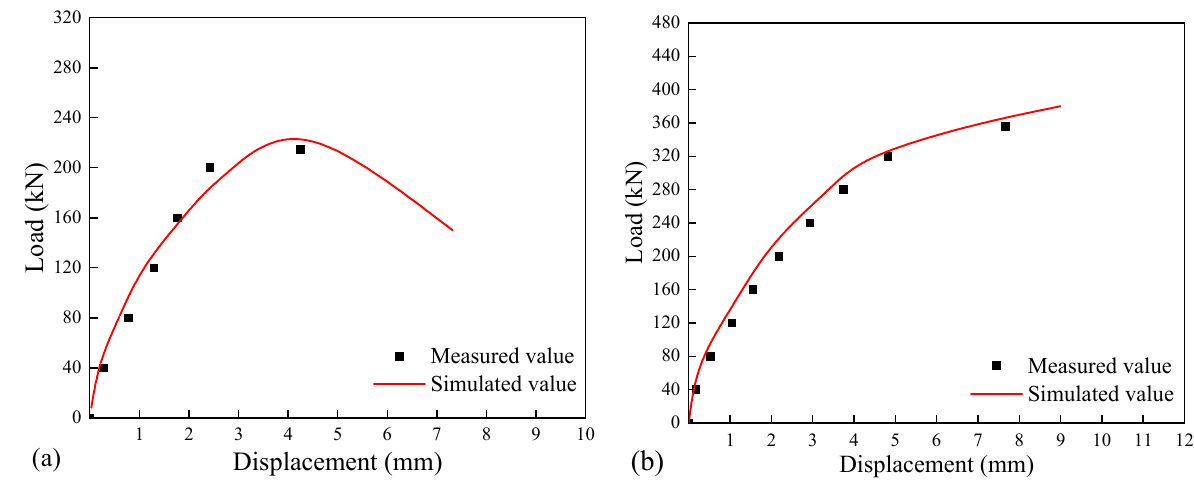
Figure 11. GFRP bolt load–displacement curves: ( a ) anchor L420, ( b ) anchor L840.